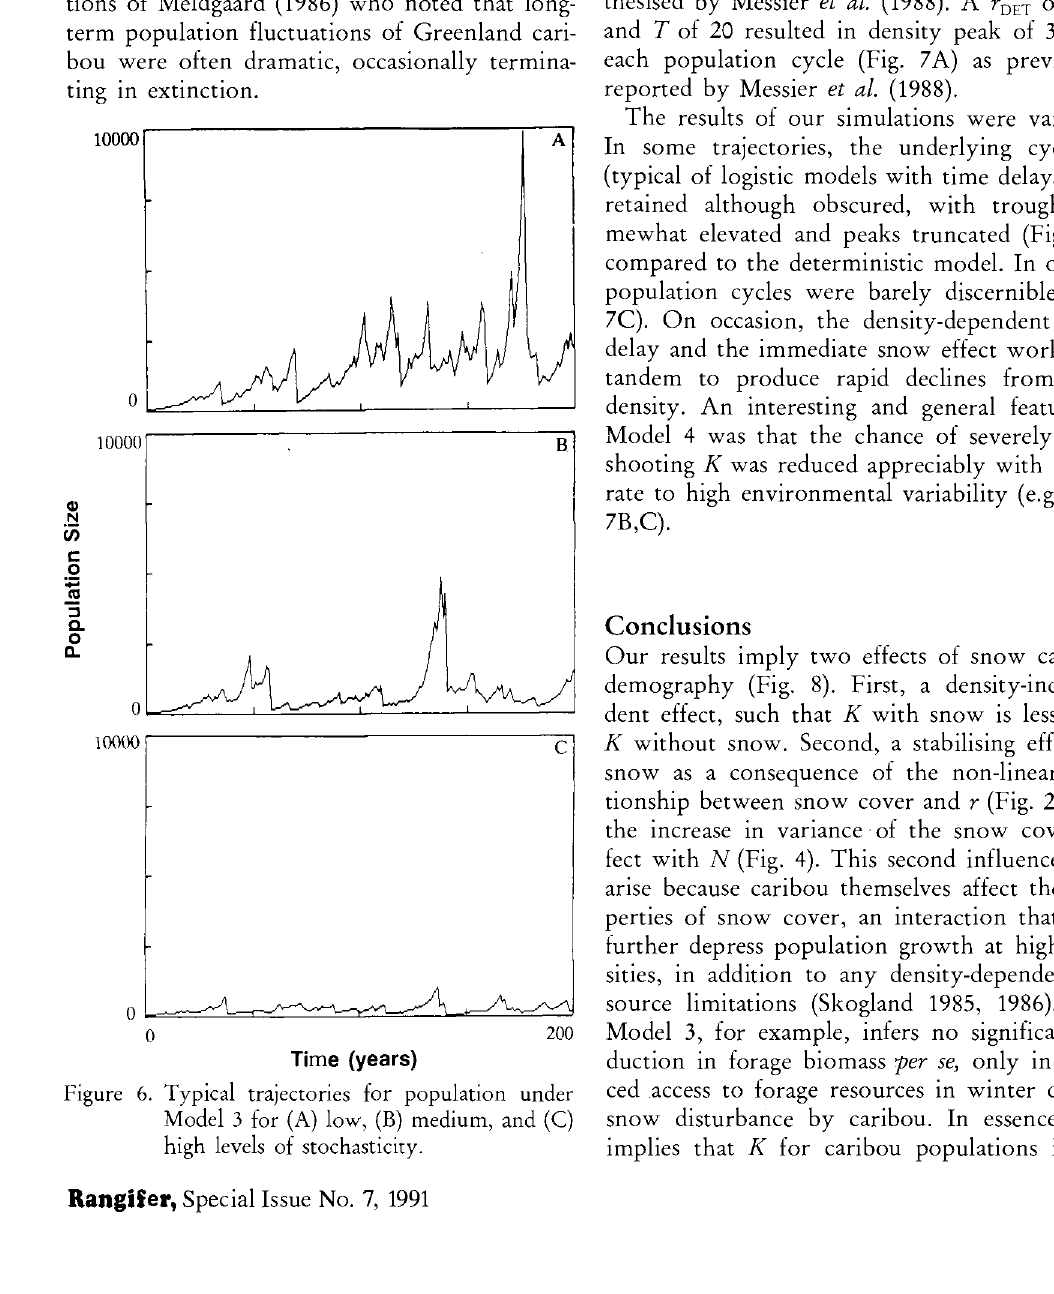
Figure 6. Typical trajectories for population under Model 3 for (A) low, (B) medium, and (C) high levels of